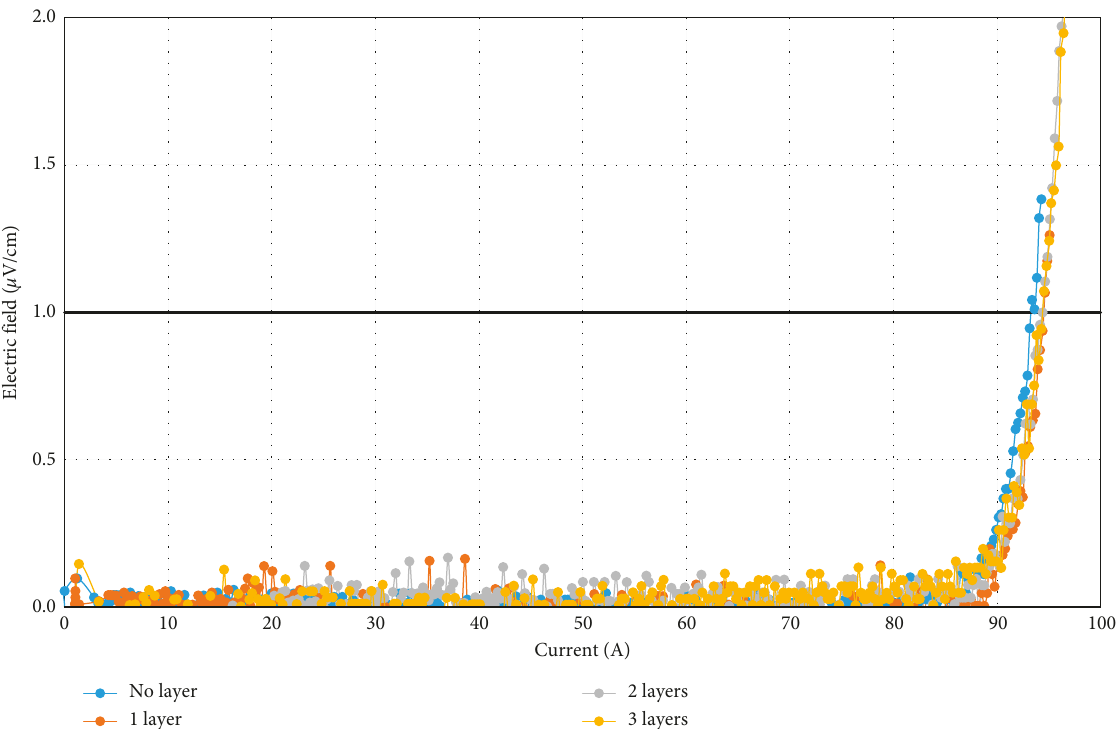
Figure 3: Current-voltage traces used to evaluate critical current of HTS tape insulated with 76.2 µ m heat shrink.